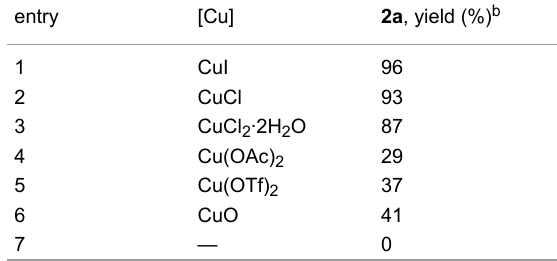
Table 2: Screening of copper sources for the copper-catalyzed reac- tion of potassium thioacetate ( 1 ) with iodobenzene. a